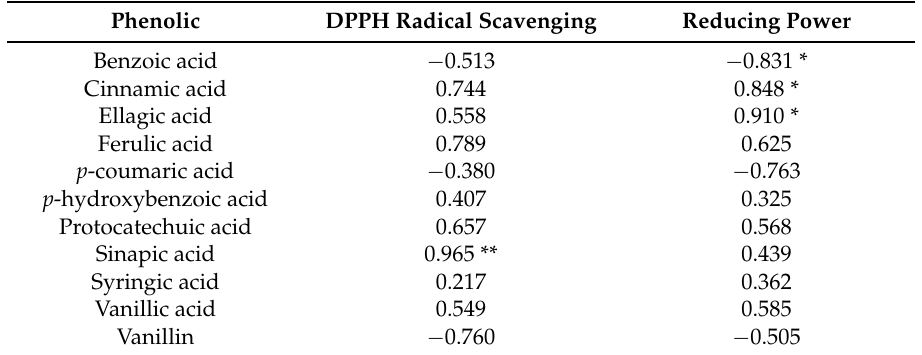
Figure 3. Correlation between reducing power and concentrations of detected phenolic acids. Table 4. Linear correlation coefficient ( R 2 ) of antioxidant activities and individual phenolic